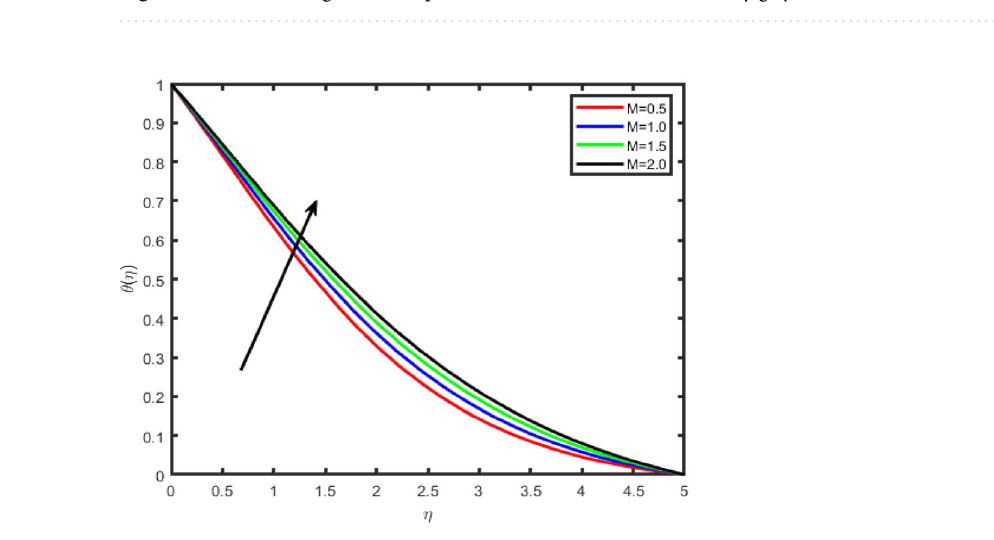
Figure 3. Effect of magnetic field parameter (M) on transverse velocity g(η).